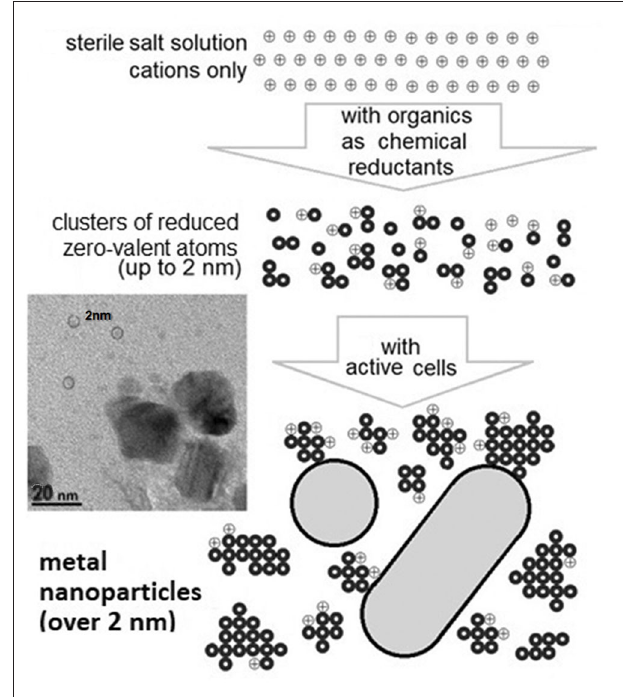
FIGURE 1 | The scheme of stages of biogenic nanoparticles